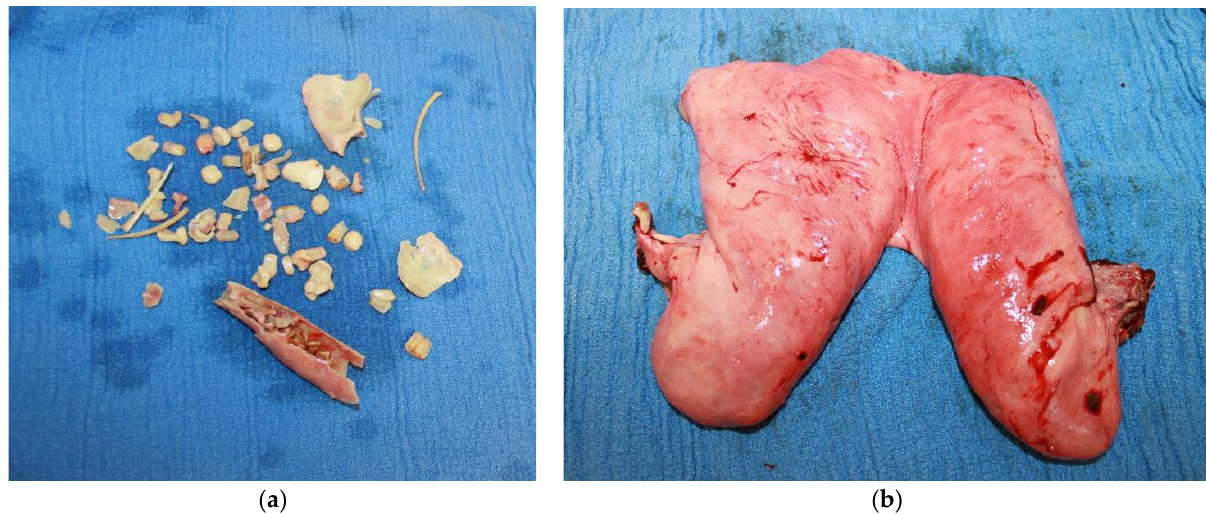
Figure 3. ( a ) Collection of fetal bones which were retrieved from the uterus post ovariohysterectomy, this includes scapulae, rib bones, and vertebral fragments. ( b ) Uterine tissue removed after subtotal ovariohysterectomy.